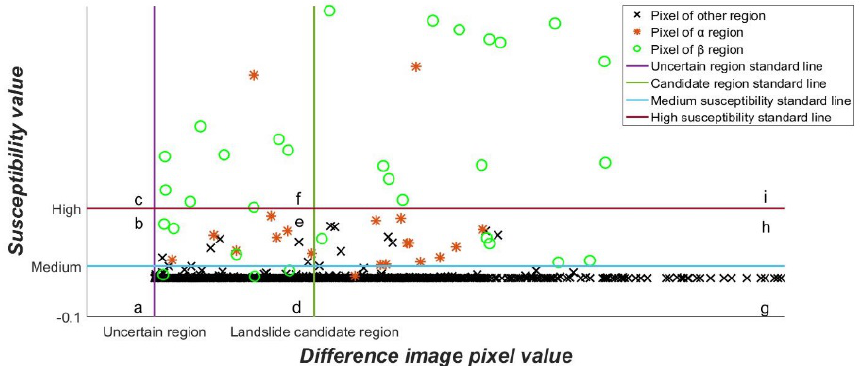
Figure 15. Scatter plot of sub-area B.